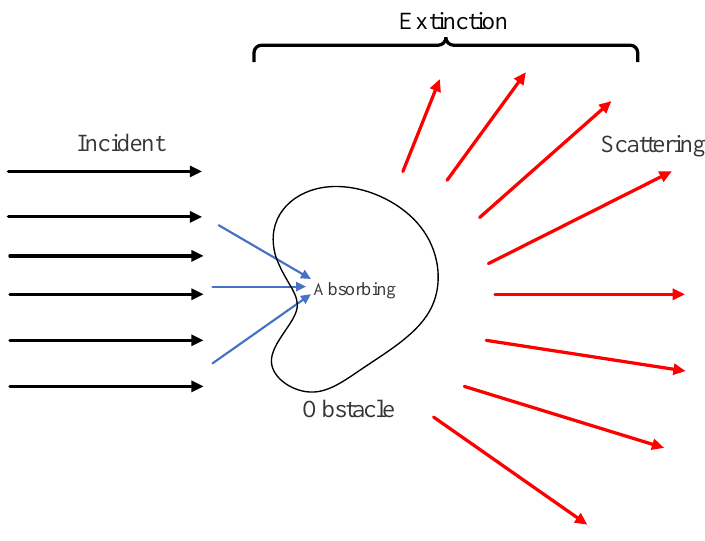
Figure 1. Obstacle absorption and scattering of incident waves.